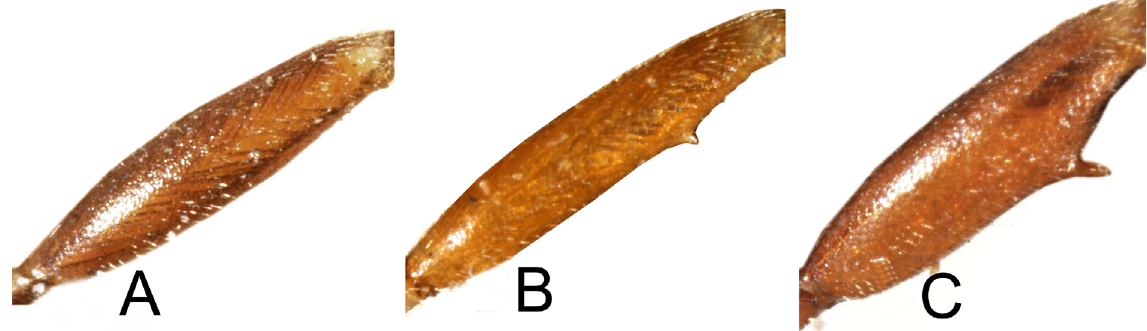
Fig. 2. Female Femoral Tooth index. A . Tooth absent (FFT = 0). B . Tooth distinct, but wider than high (FFT = 1). C . Tooth higher than wide (FFT =